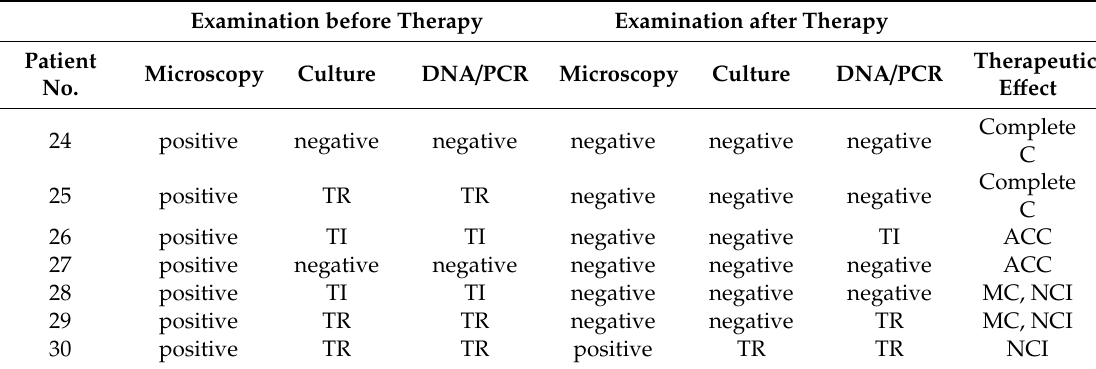
Table 5. Therapeutic e ff ect of NPAR combined with NTP, Protocol